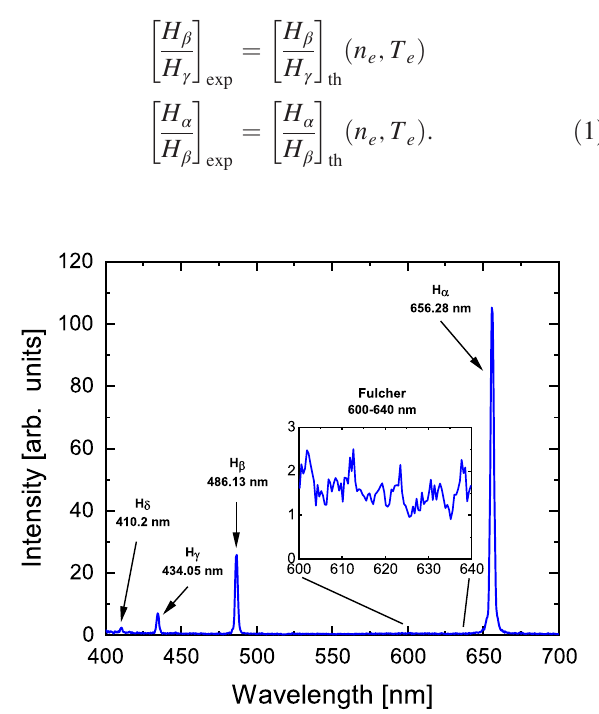
FIG. 3. Hydrogen spectrum acquired at 400 W microwave power, 2.45 GHz microwave frequency,and at pressure of 2 . 7 × 10 − 5 mbar. Balmer line series and Fulcher band are